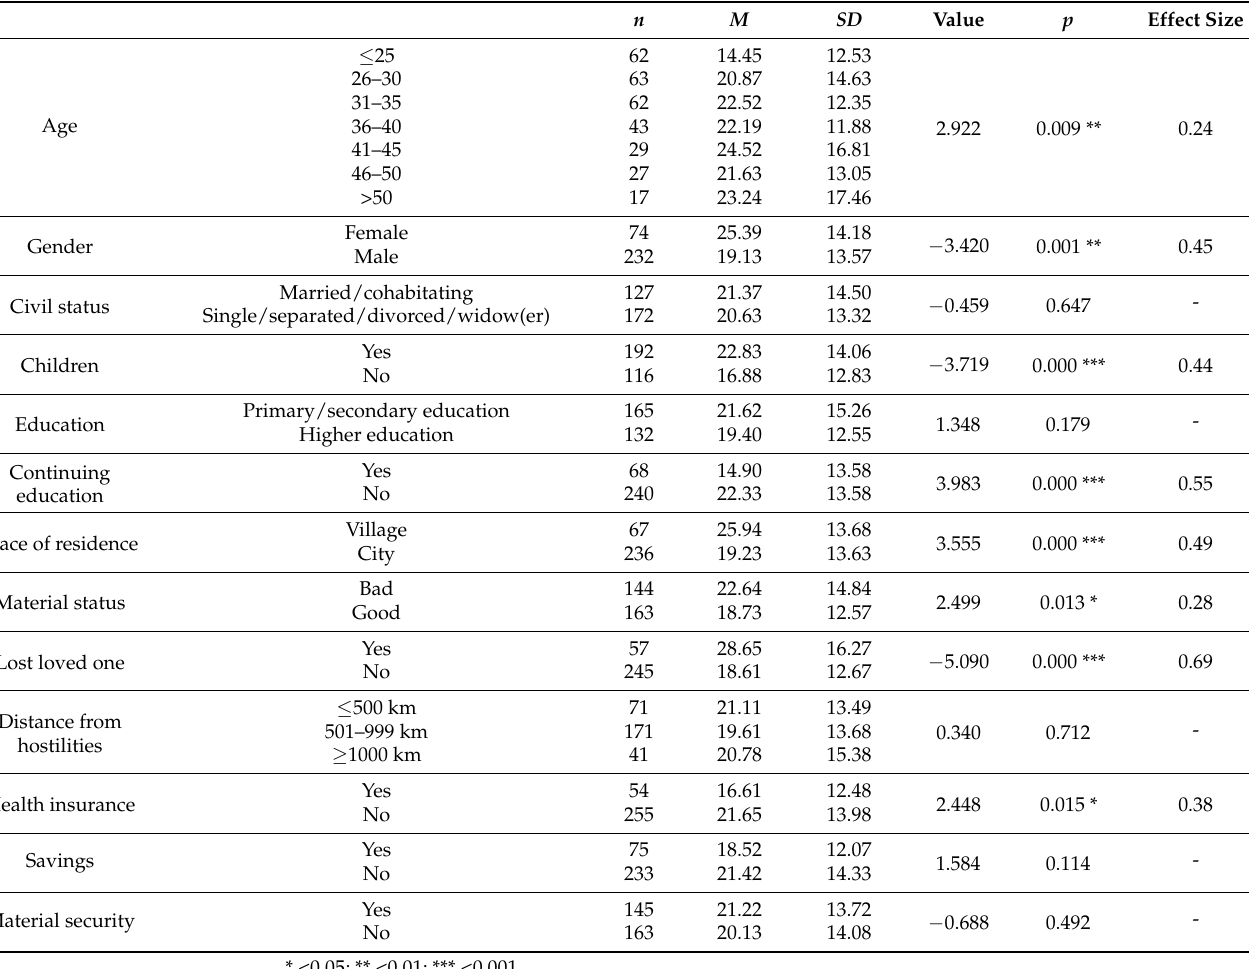
Table 1. Parametric test results for PTSD score.